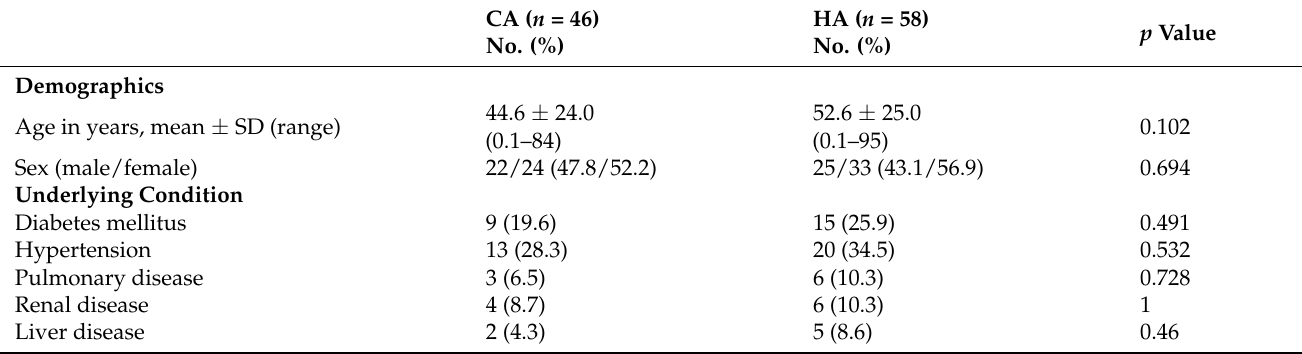
Table 1. Comparison of demographics and systemic and local factors between patients infected with community-associated and health-care-associated methicillin-susceptible Staphylococcus aureus ocular